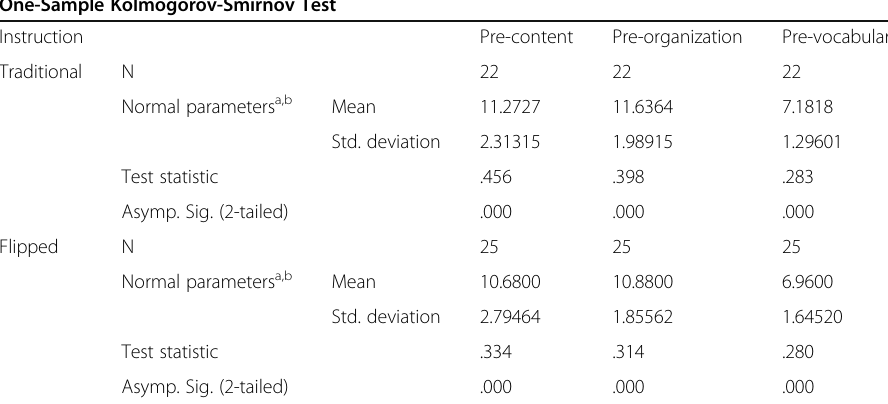
Table 8 Test of normality (pre-content, pre-organization, and pre-vocabulary) One-Sample Kolmogorov-Smirnov